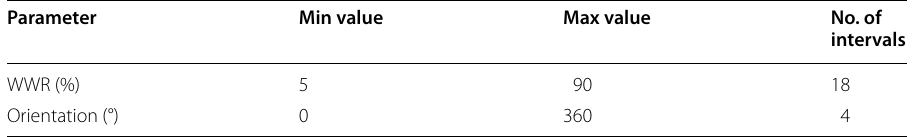
Table 7 Variable parameter for the case study